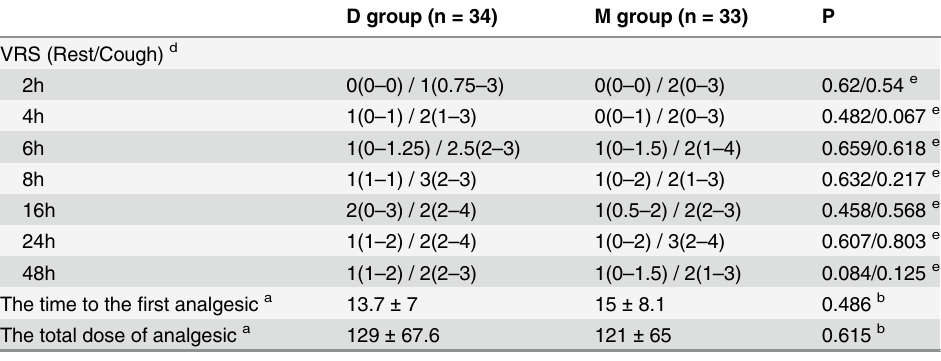
a Values are mean ± SD. b Independent two-sample t-test d Values are median (interquartile range)